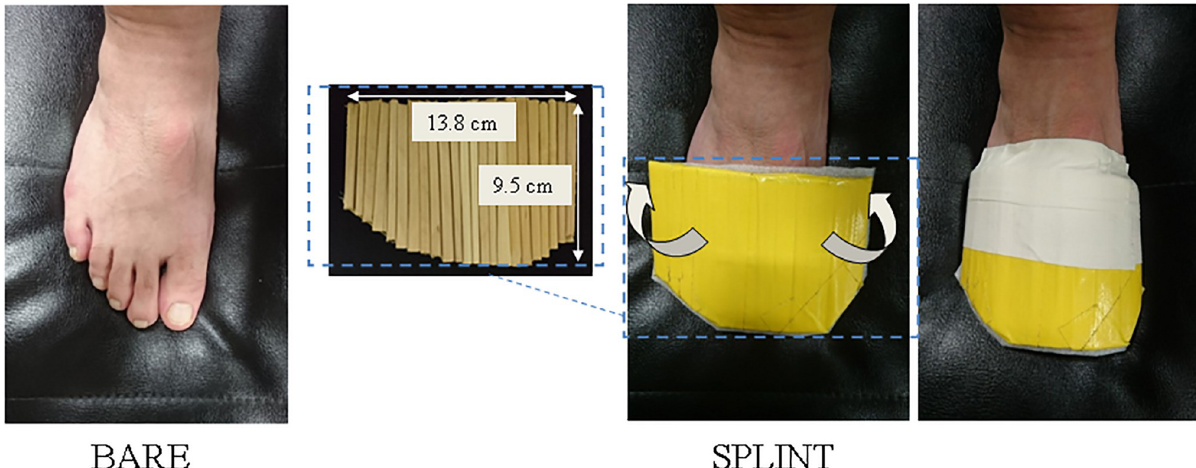
Fig 1. Forefoot immobilisation (FFIM) with a splint. Several pieces of wood sticks were cut and adjusted to the length of the forefoot, and these pieces were jointed parallel with vinyl tape so that this splint could be bent in a small range at the sagittal plane of the foot. The size of the splint was approximately 9.5 cm long, 13.8 cm wide and 48.0 g. The splint was fixed on the dorsal side of the dominant forefoot by taping. White arrows show the direction of overlap around the dorsal side of the forefoot.